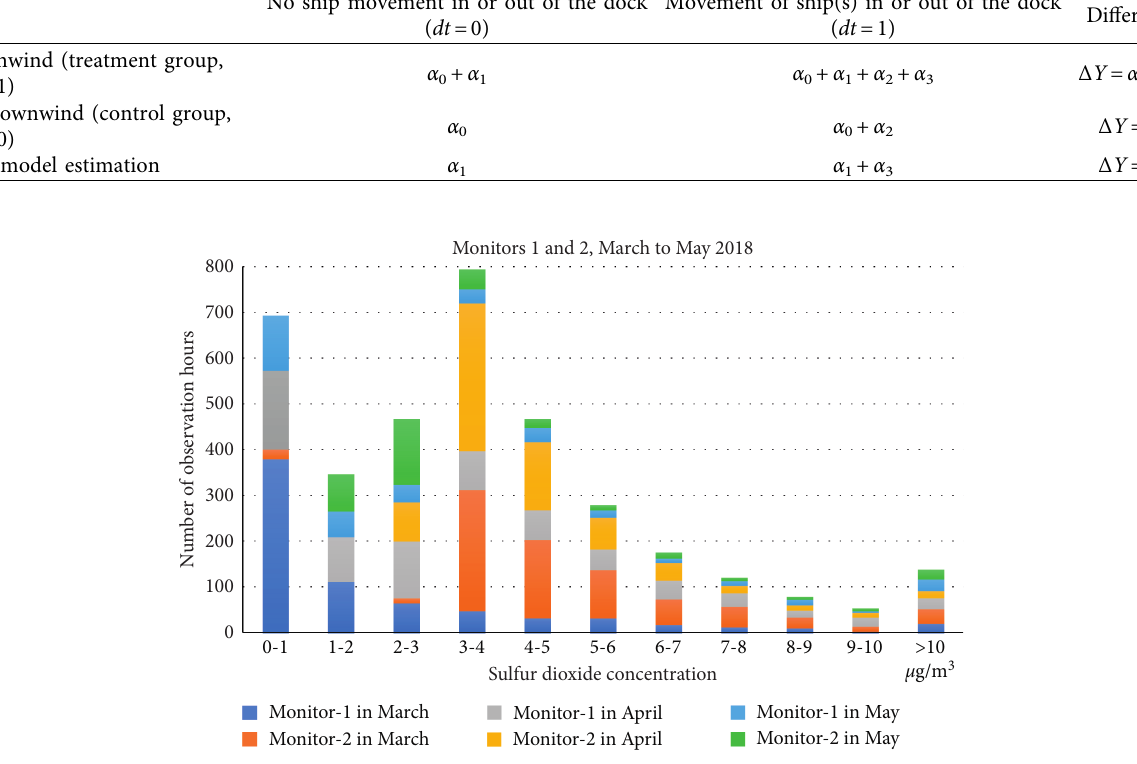
Figure 2: Overall distribution of the average SO 2 concentrations per hour observed at the two monitoring points, where the interval is 1 µ g/ m 3 , and the number of observation hours in each concentration interval were counted.